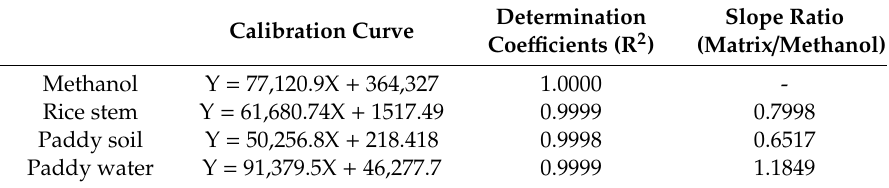
Table 1. Calibration curve of emamectin benzoate in rice stems, soil, and field water ( n = 5).